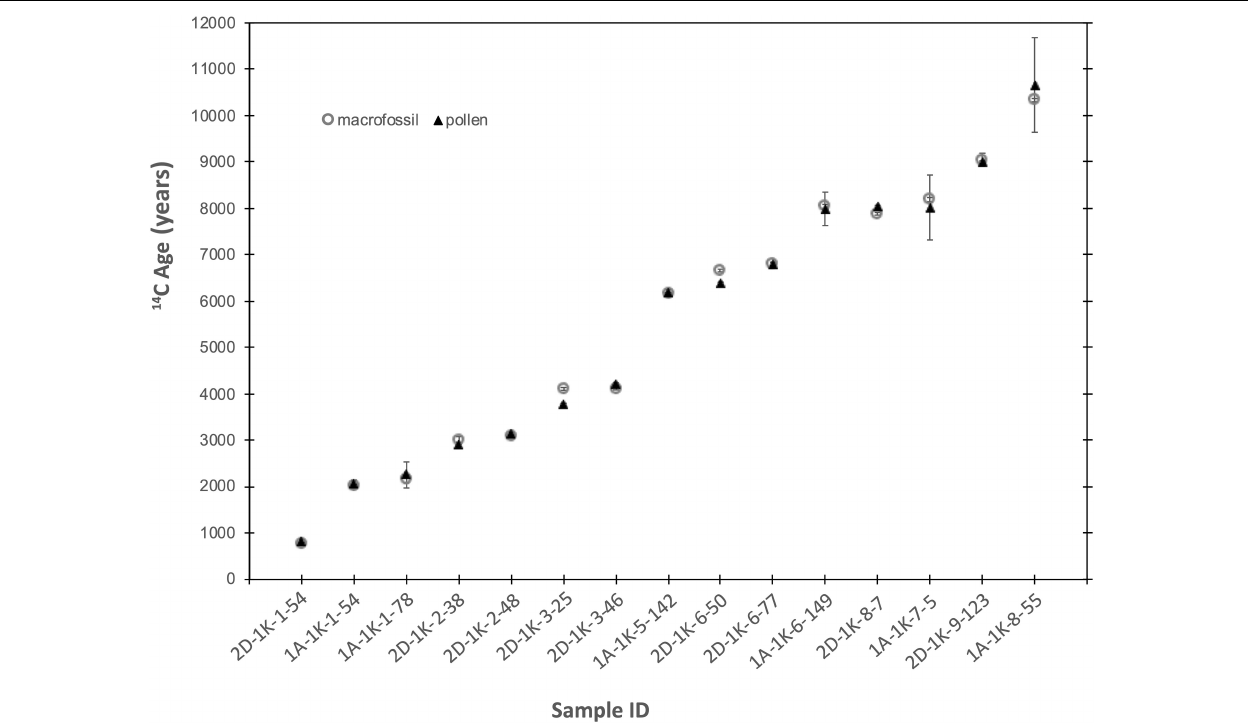
FIGURE 6 | Comparison between macrofossil and pollen dates from FLL sediment core. Samples names refer to the core section and the section depth of the sample.